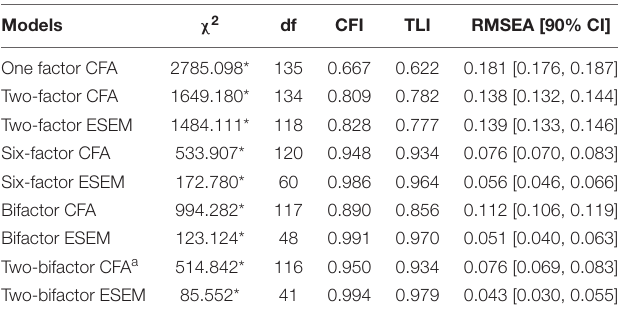
TABLE 2 | Standardized factor loadings for the bifactor-ESEM solution for the Japanese version of the State Self-Compassion Scale in Study 1. SC ( λ